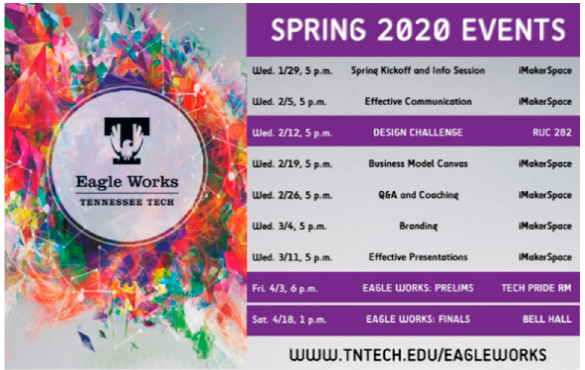
Figure 9. Spring 2020 programs hosted by iMakerSpace .